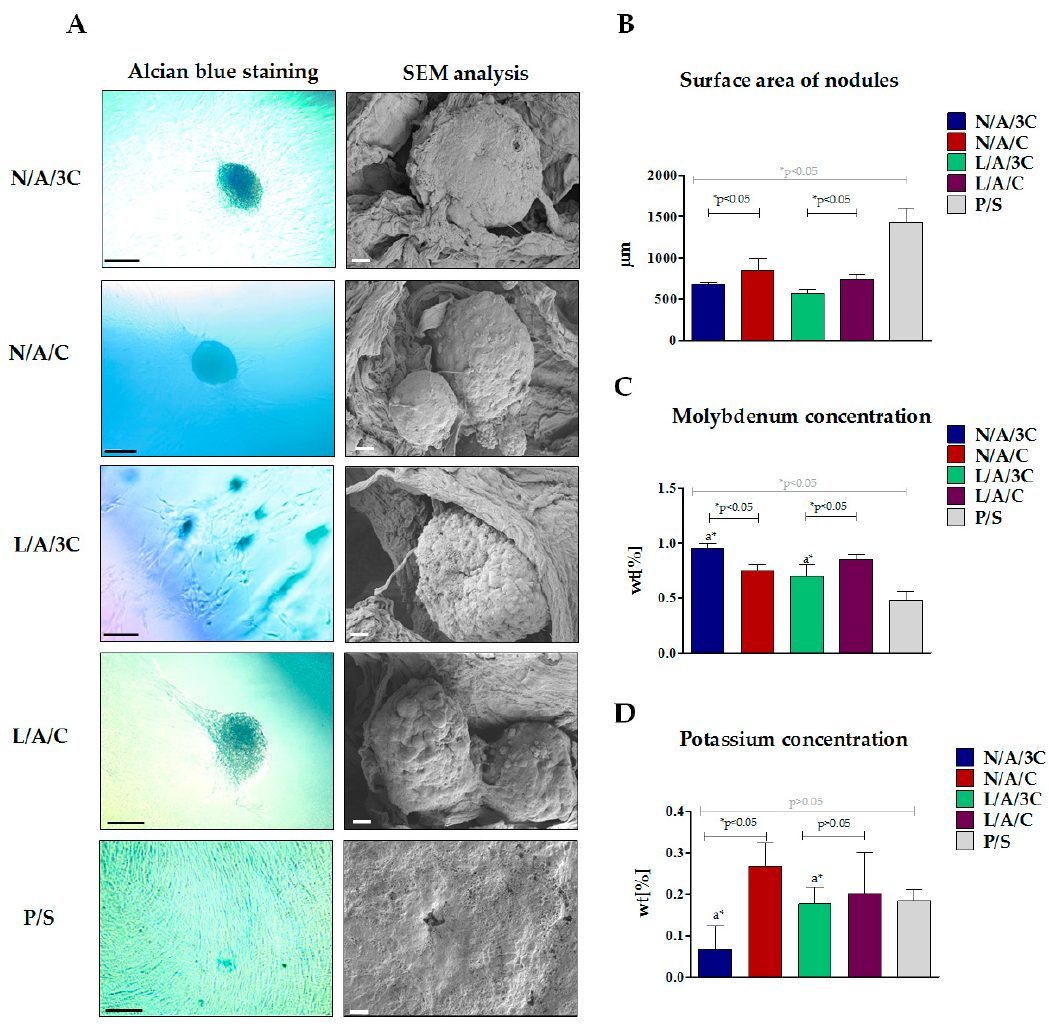
Figure 13. Characterization of chondrogenic cultures of hASC in 3D (AC sponges) and 2D systems (polystyrene). The Alcian Blue staining and SEM analysis of chondrogenic nodules; scale bar = 100 µ m and for microphotographs = 2 µ m ( A ). The results of surface area of nodules determination ( B ). Analysis of chondrogenic nodules elemental composition in relation to molybdenum ( C ) and potassium ( D ) concentration. An asterisk (*) indicates a statistically significant difference ( p <